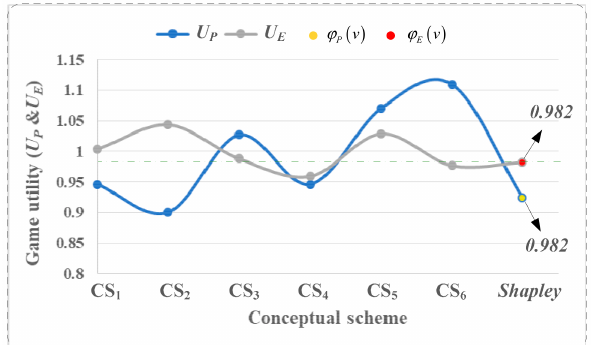
Figure 4. Game utility of CV and economic objective under different solutions and Shapley